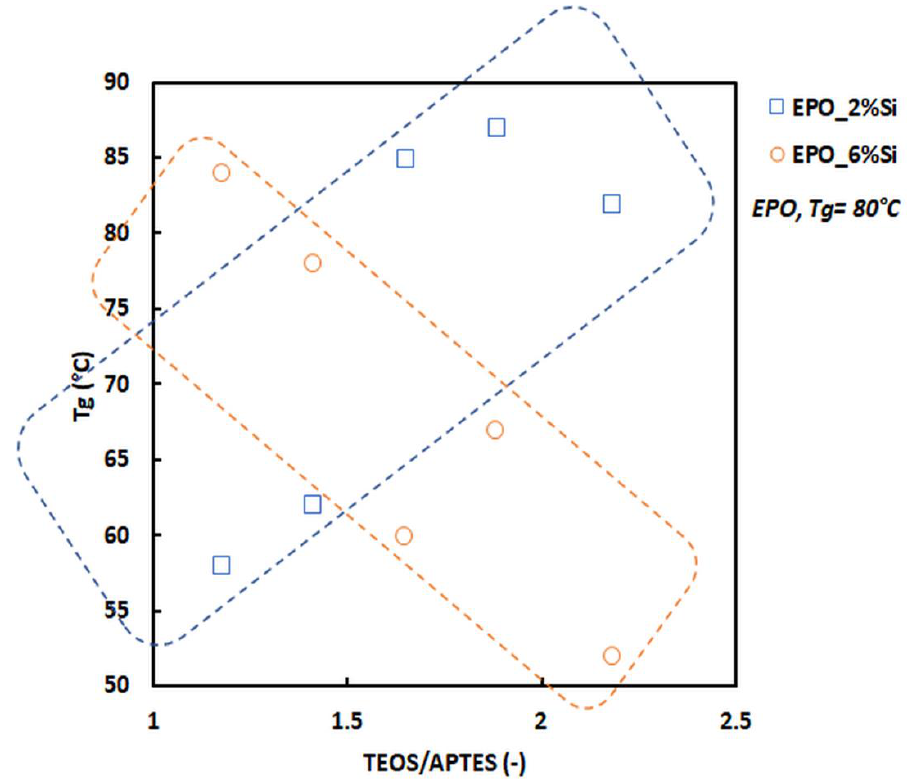
Figure 3. T g vs. TEOS/APTES molar ratio for the nanocomposites at 2 (blue labels) and 6 wt.% (orange labels) of silica. In particular, blue squares represent the samples containing 2 wt.% of silica; orange circles indicate samples containing 6 wt.% of silica. The dotted blue line highlights the T g values of all formulations containing 2 wt.% of silica at different TEOS/APTES ratios, while the dotted orange line identifies the T g values of all formulations containing 6 wt.% silica at different TEOS/APTES ratios.